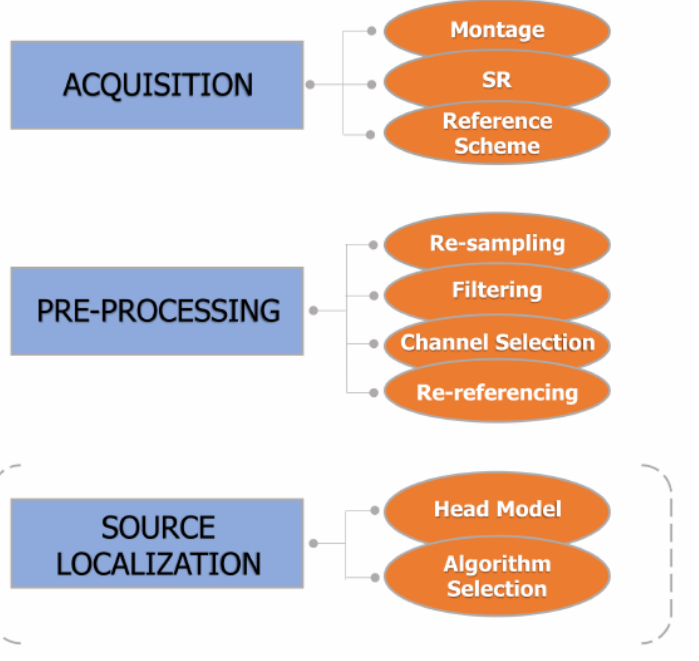
Figure 3. Main steps in EEG acquisition and pre-processing. In general, source localization is not mandatory, as represented by the dashed round